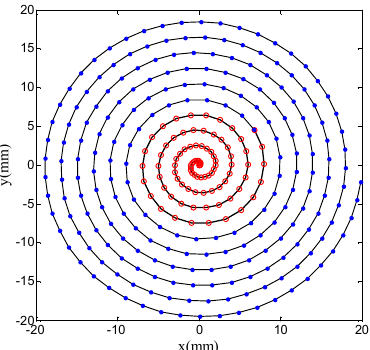
Figure 8. The recombination result of constant angle and constant arc-length method.